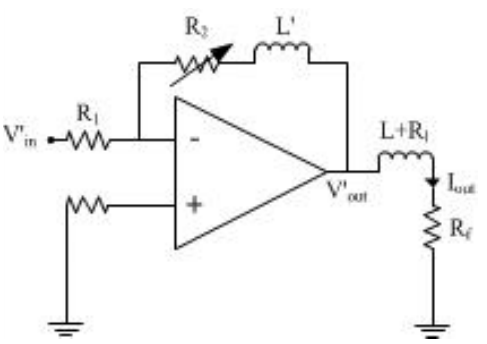
Figure 11. The circuit of the power